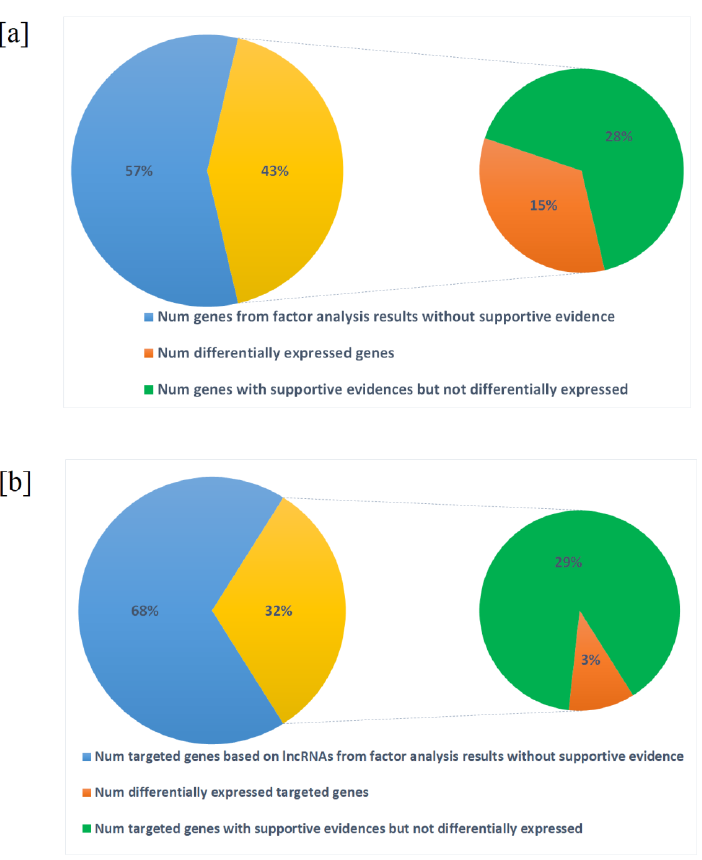
Figure 4. Portion of differentially expressed genes/lncRNAs versus genes/lncRNAs with at least one supportive evidence: ( a ) coding genes after factor analysis; ( b ) targeted coding genes based on lncRNA genomic locus.